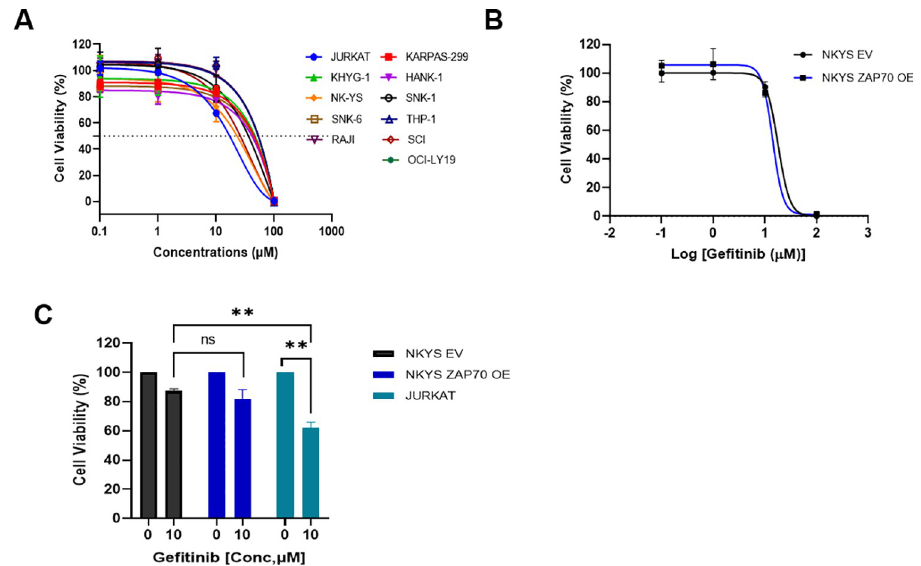
Fig 5. Gefitinib does not preferentially target ZAP-70 overexpressing NKTL. (A) Gefitinib dose response curve for TCL cell lines (JURKAT, KARPAS-299), NKTL cell lines (KHYG1, HANK-1, NK-YS, SNK-1, SNK-6), monocytic leukemic cell line (THP-1) and B cell malignant cell lines (RAJI, SCI, OCI-LY19) (B) NKYS cell lines which have been stably transfected with EV or ZAP70 were treated with a range of Gefitinib concentrations and cell viability assessed by Cell–Titer Glo (Promega) (C) Jurkat a high ZAP-70 expressing T cell leukemia cell line is a positive control with growth inhibition induced by